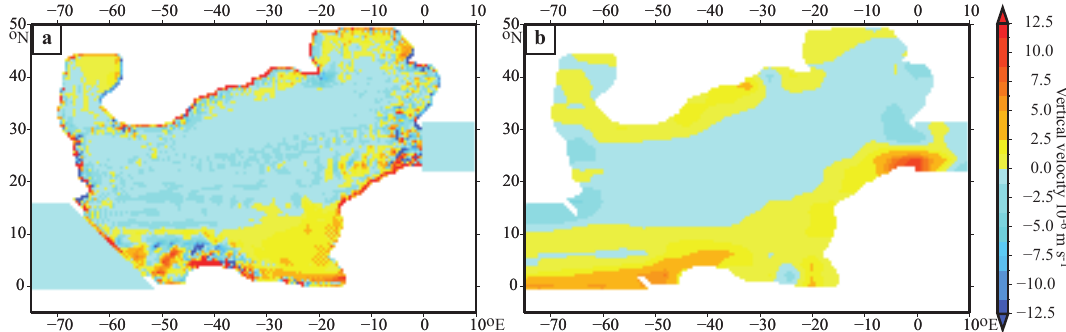
Fig. 5. Upwelling. Mean vertical velocity at 40m from (a) REF and (b) the Cenomanian CCSM3 run. Upward velocities are positive and downward negative. 10 × 10 − 6 ms − 1 corresponds to ∼ 0.86mday − 1